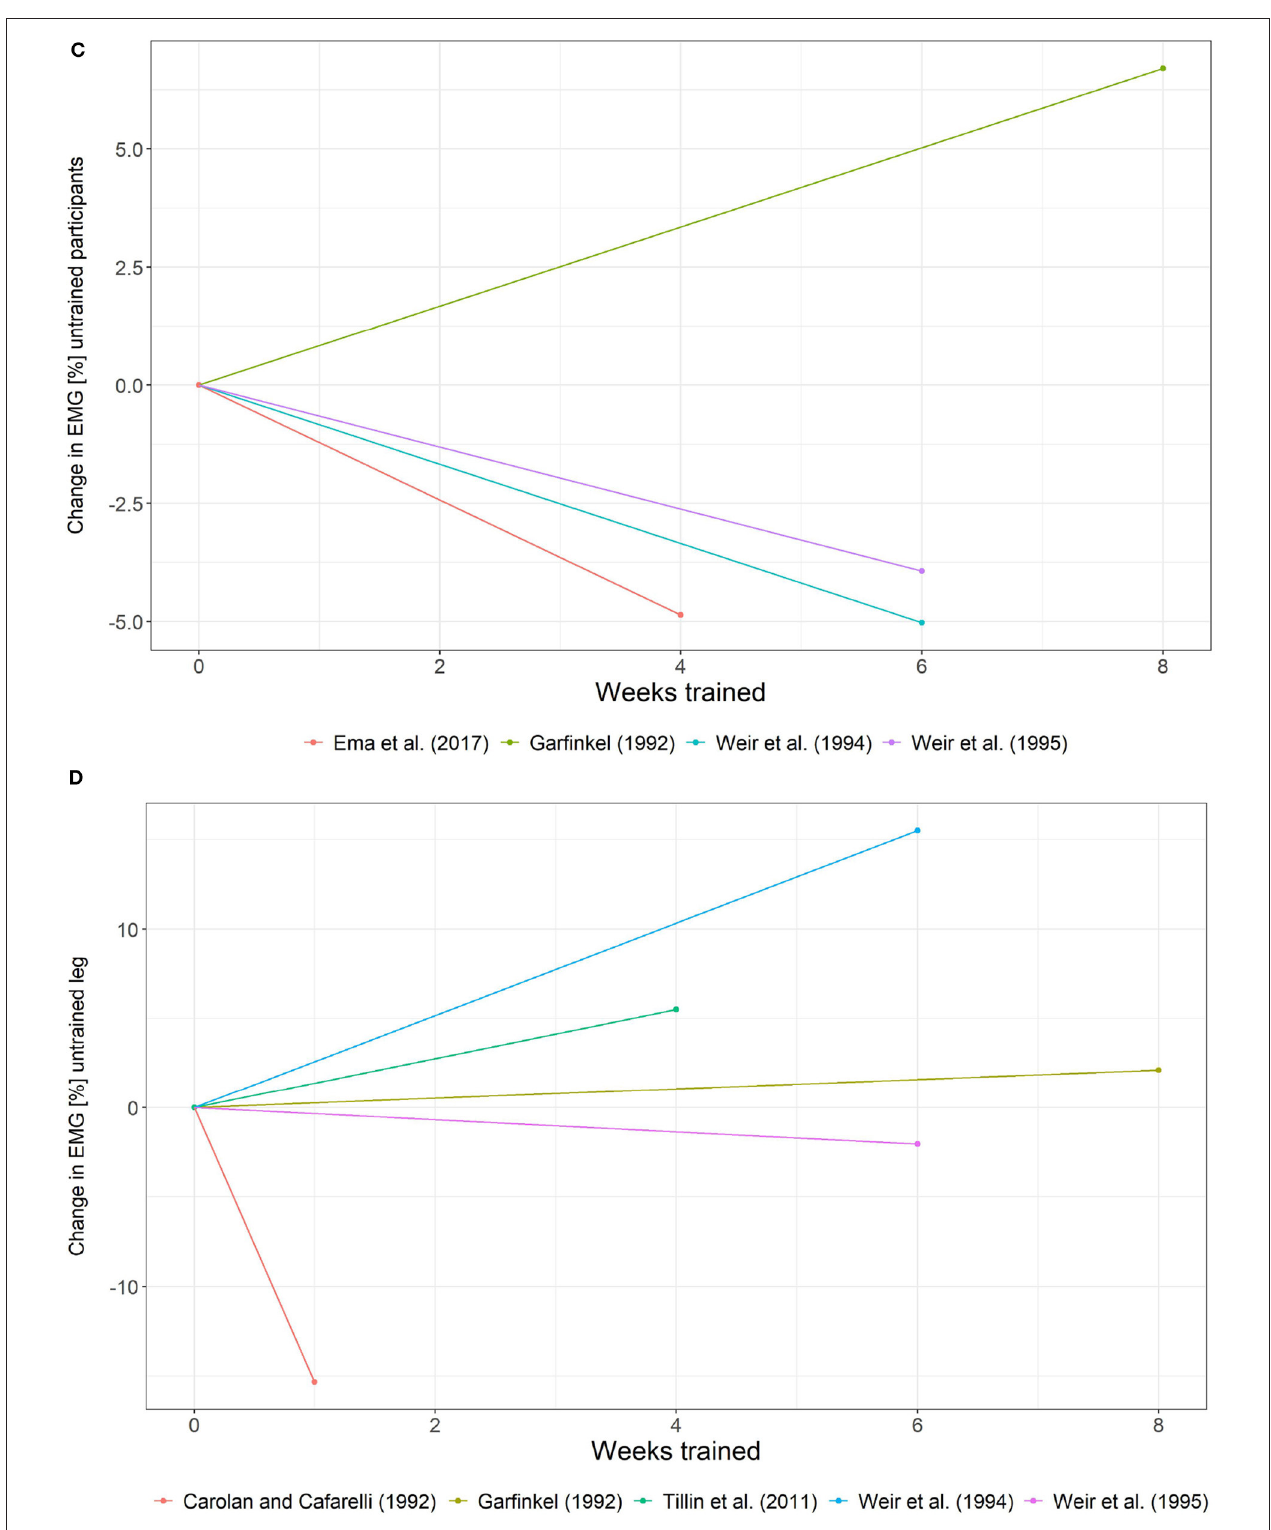
FIGURE 7 | Change in isometric strength and EMG for the control group and untrained leg data. (A) Control group data for change in isometric strength. (B) Untrained leg data for change in isometric strength. (C) Control group data for change in EMG. (D) Untrained leg data for change in EMG.